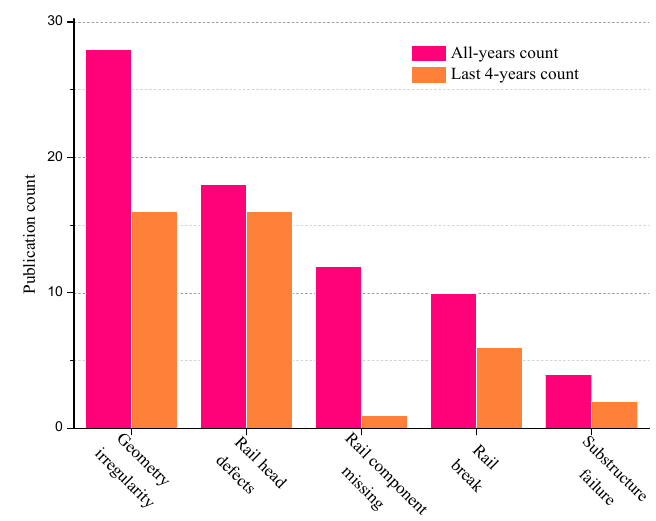
Figure 5. Publication count by track defects.